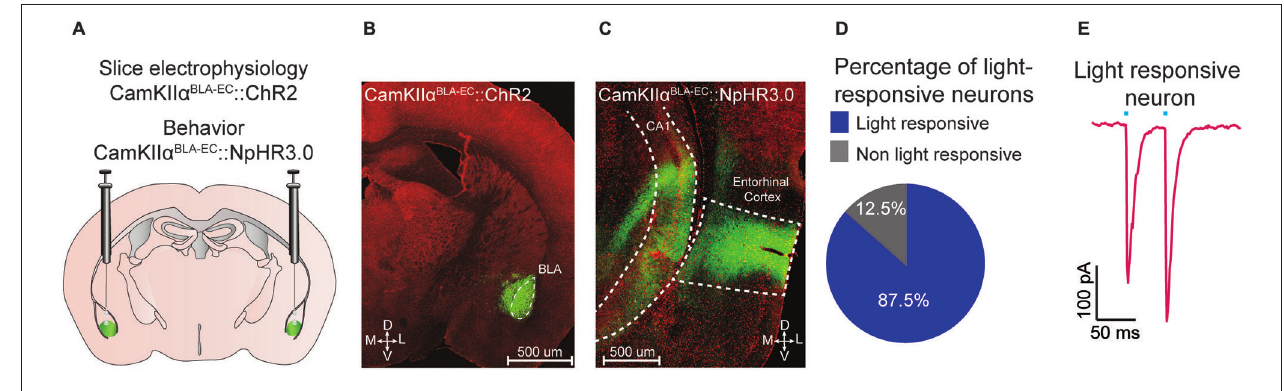
scale bar = 500 µ m). (C) A representative coronal section of the EC with expression of ChR2-eYFP (green) in glutamatergic fibers originating from the BLA (scale bar = 200 µ m). (D) Percentage of light responsive vs. non-light responsive neurons in the EC following photostimulation of BLA glutamatergic fibers. (E) Example trace of a light responsive neuron in the EC. All values for all figures represent mean ±